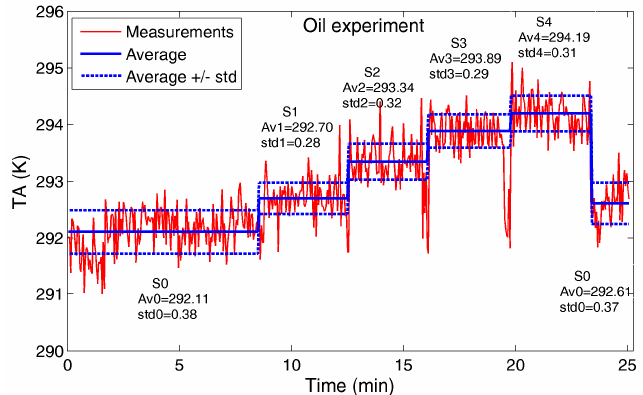
Figure 7. Oil experiment: antenna temperature T A measured by the radiometer. For each setting (S0, S1, S2, S3 and S4), average (AvN) and standard deviation (stdN) are reported in Kelvin. The T A mean increment is around 0.6 K adding the first water bin (S1), and in the range 0.3–0.65 K adding the bins in sequence.